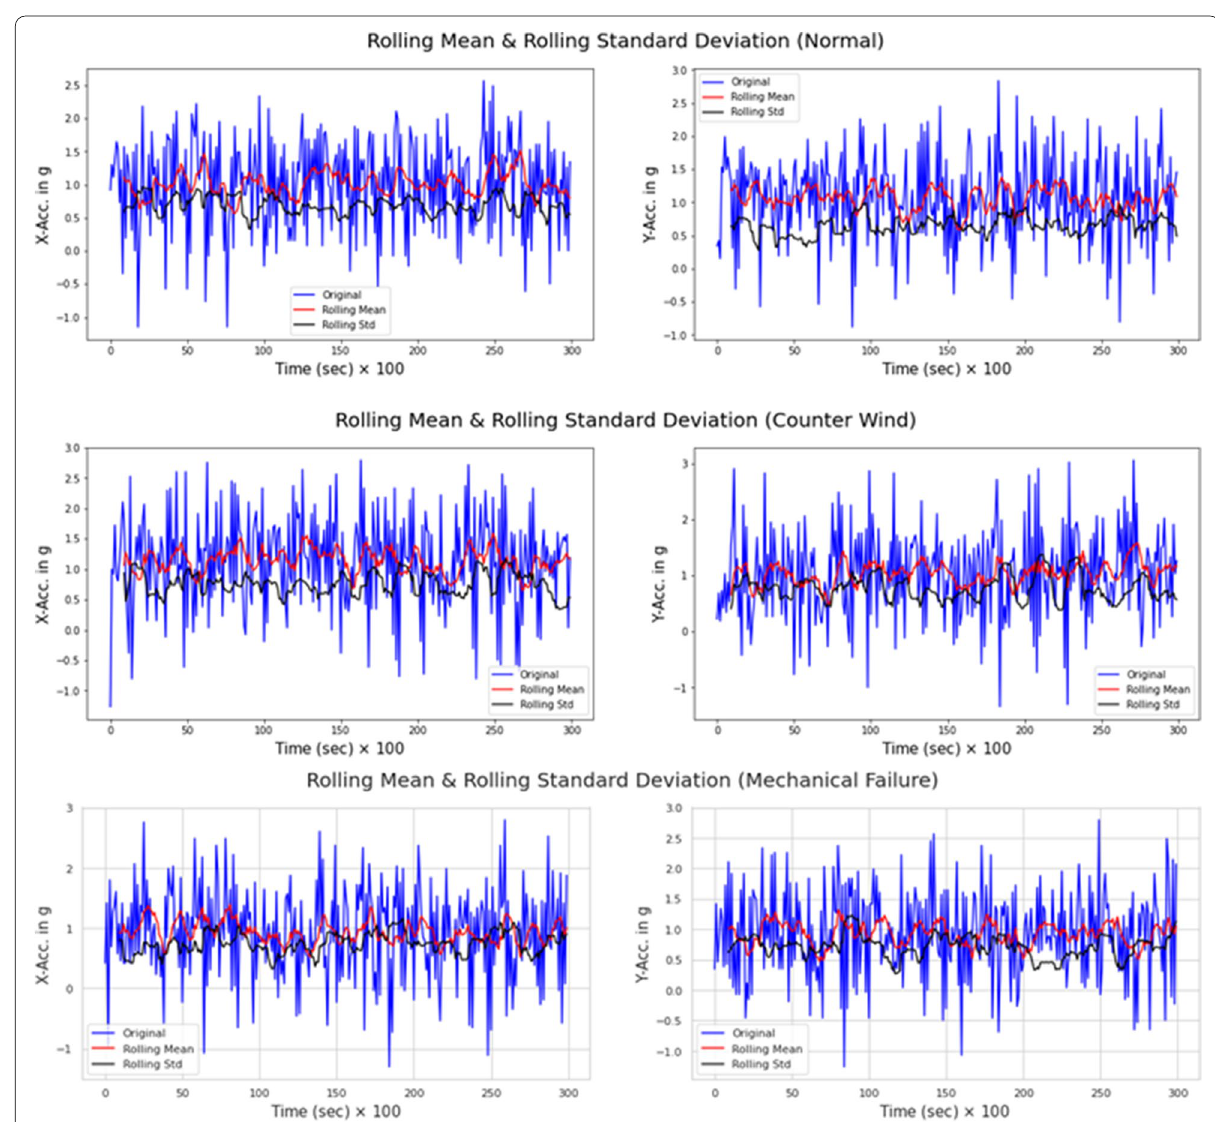
Fig. 9 Experimental time series data for three states of the fan: Normal state (top row), counter‑wind state (middle row), and mechanical failure state (bottom row). Raw data from the accelerometer overlaid with the rolling mean and standard deviation. Each row represents both x (left) and y (right) acceleration in g